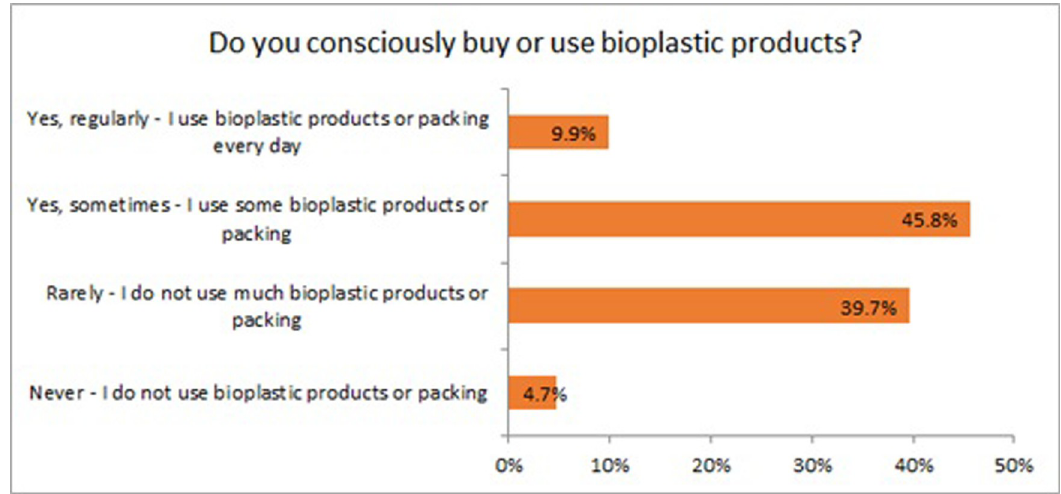
Fig 3. Conscious purchase and consumption of bioplastic products (n =